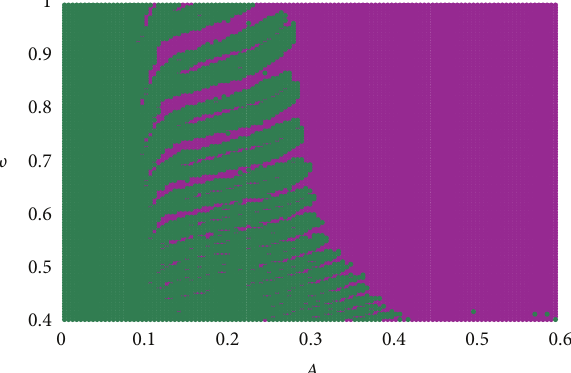
Figure 6: Two-dimensional dynamical behavior distribution on 𝐴 - 𝜔 plane (colored figure online).